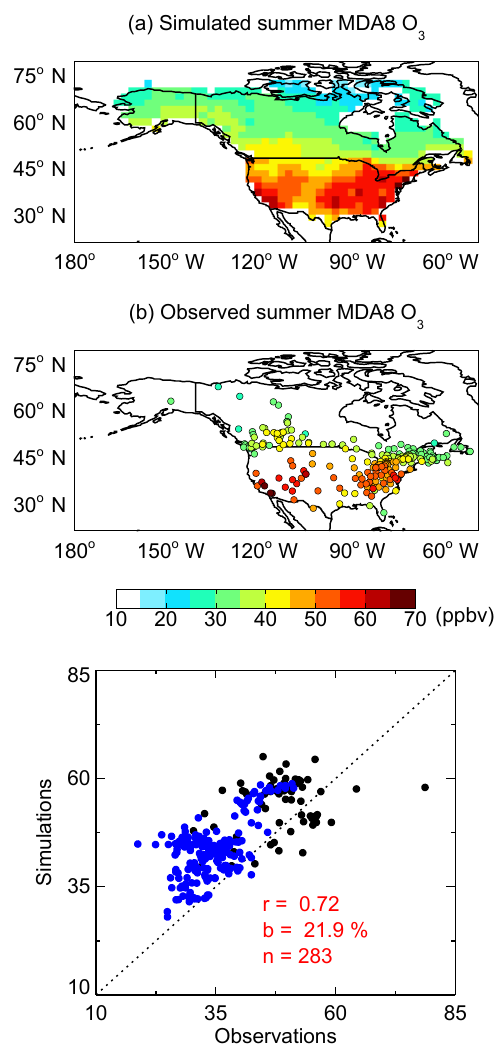
Figure 4. Evaluation of simulated summer surface maximum daily 8h average [O 3 ] with observations for 2008–2012. Observations are collected from 81 US sites at the Clean Air Status and Trends Network (CASTNET) and 202 Canadian sites at the National Air Pollution Surveillance (NAPS) program. The number of points ( n ), correlation coefficient ( r ), and mean bias ( b ) for the evaluation are presented on the plot. Values over Canada and Alaska are denoted with blue